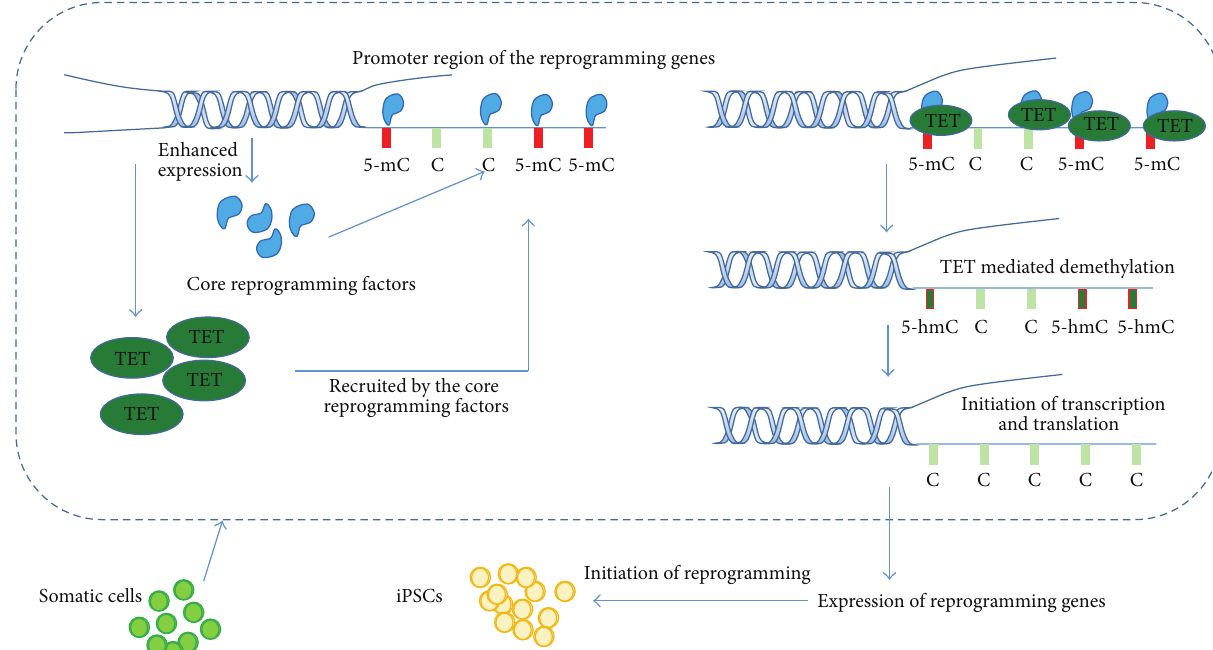
Figure 2: Enhanced expression of the core reprogramming factors and TETs switches the cell fate towards nucleic reprogramming to generate iPSCs. The TET enzymes are recruited by core transcription factors and localized to the methylated promoter regions of the downstream genes involved in the reprogramming. Then the TET oxidizes the 5-mC into 5-hydroxymethylcytosine (5-hmC) that serves as mediator of demethylation of the 5-mC, leading to demethylation of the promoter regions and expression of these genes and thereby initiation of the reprogramming.